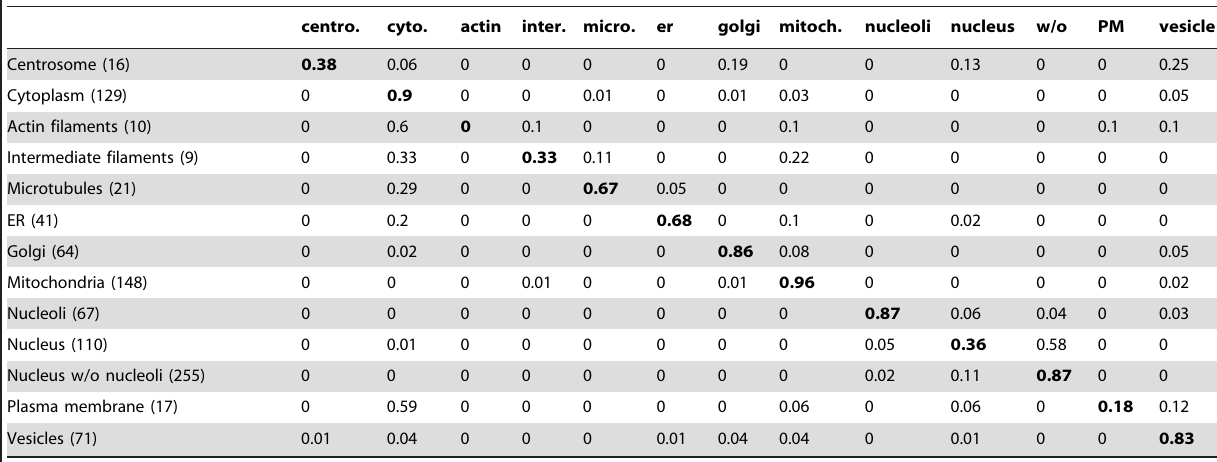
Table 3. Classification results before second round of reannotation.